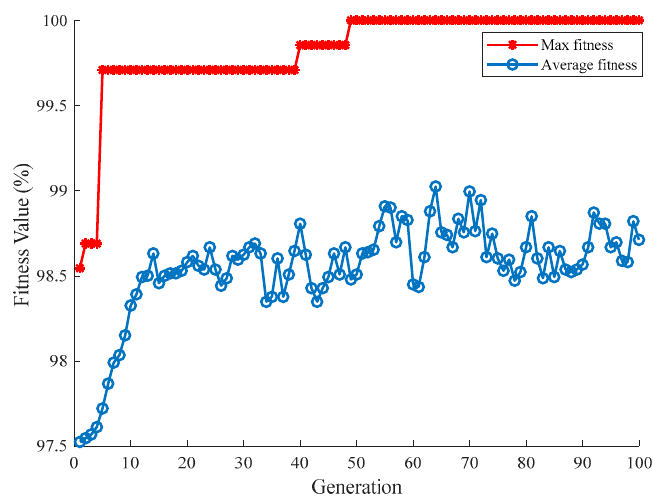
Figure 3. Fitness curve of GA optimizing parameters, and the identification accuracy reaches nearly 100% after 49 generations.